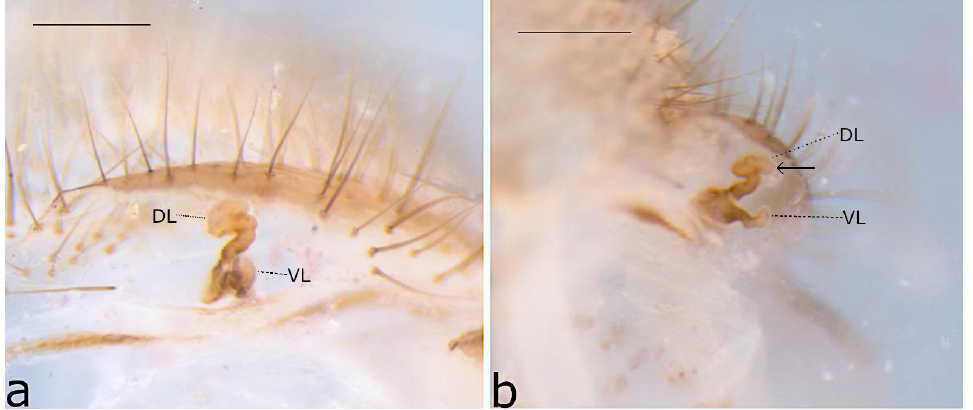
Figure 76. Ariadna woinarskii sp. nov. ♀ (SAMA NN31203) from Kangaroo Island (SA): anterior receptaculum ( a ) ventral view; ( b ) same, lateral view, ventral facing apical fold on DL indicated by arrow. Scale bar ( a ) = 0.2 mm and ( b ) = 0.25 mm. DL = dorsal lobe, VL = ventral lobe. Pedipalp: Densely covered in dense black setae, with numerous macrosetae prolater- ally. Genitalia: (Based on female SAMA NN31202) The anterior receptaculum is bilobed, both the ventral and dorsal lobes are elongate and sinuous, the ventral lobe being strongly sinuous when viewed ventrally; and with a distinct ventral facing fold apically (Figure 76a,b).